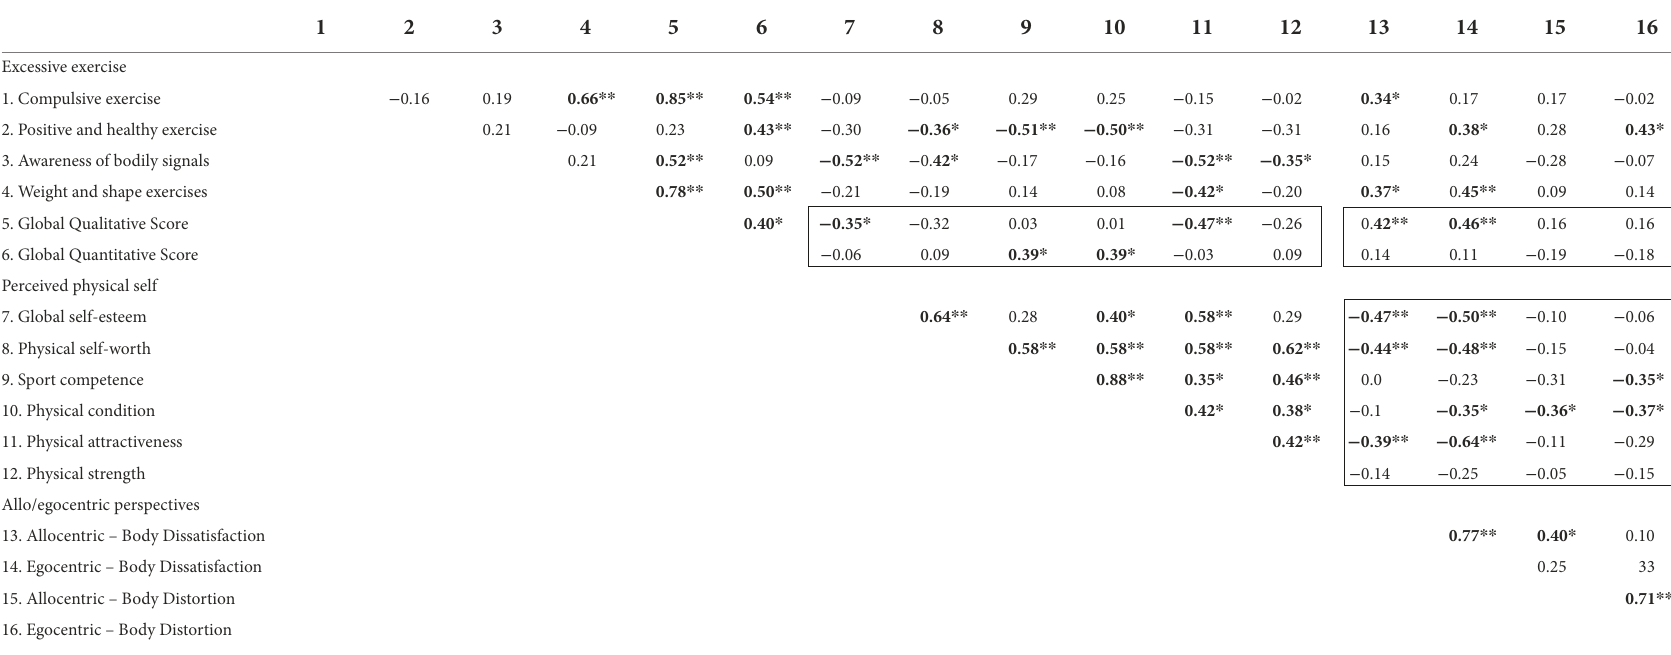
TABLE 2 Pearson’s correlations among qualitative and quantitative dimensions of excessive exercises, dimensions of the physical self, and allocentric/egocentric perspectives of body image in a sample of young adults with ED, with correlations of main interest identified by boxes ( N =